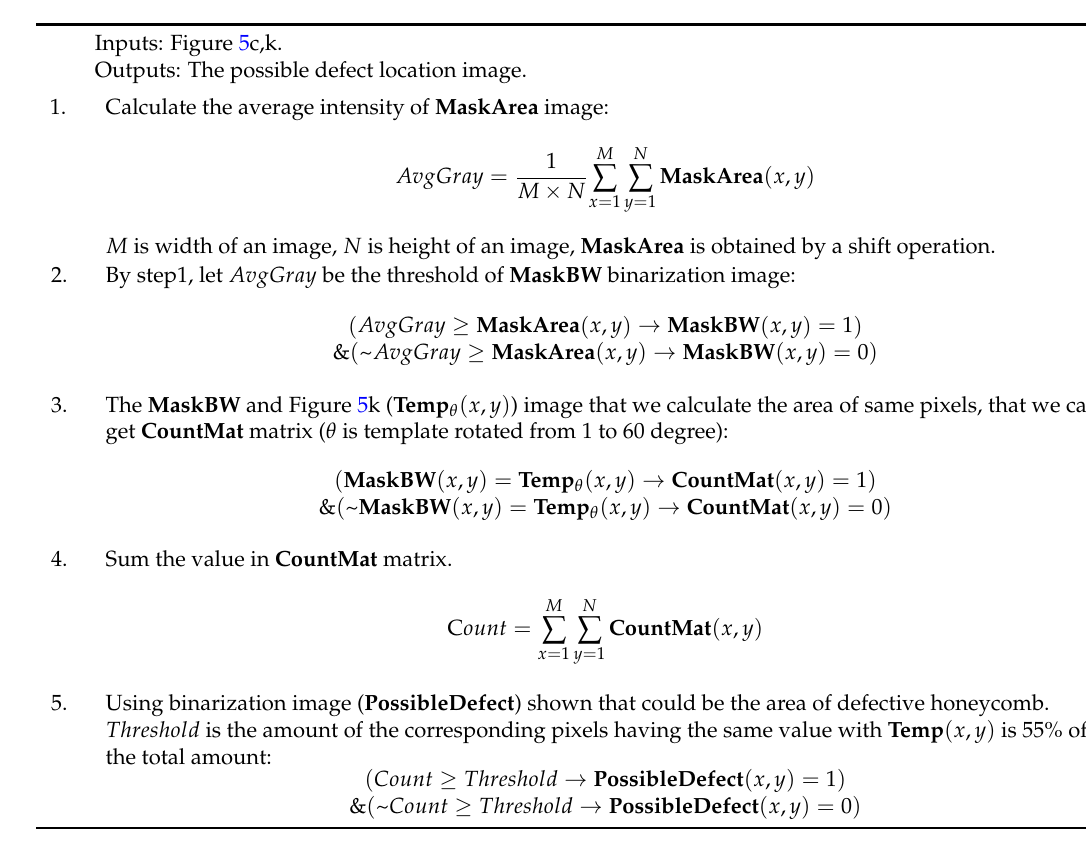
Table 3. The process for defect location